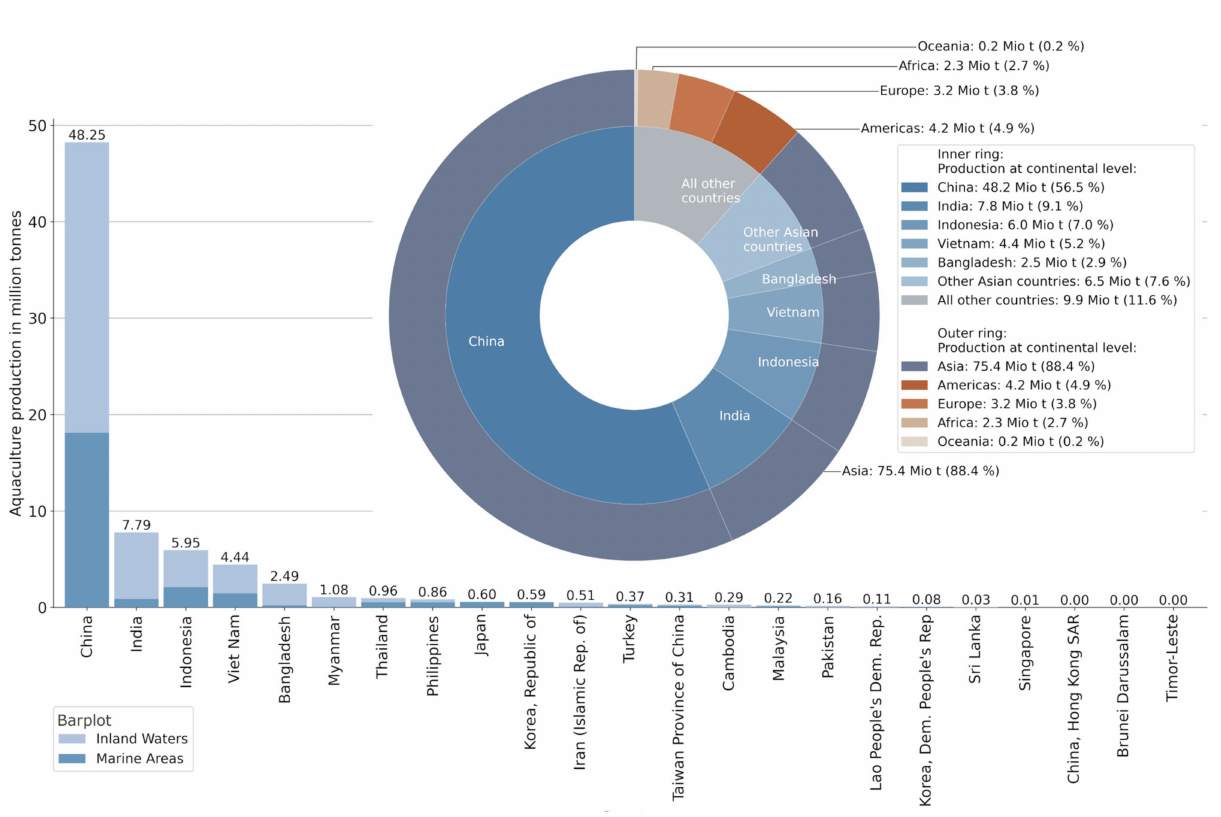
Figure 2. Bar chart: Aquaculture production in inland waters and marine areas among Asian countries in 2019; Donut chart: Share of aquaculture production among continents and the top 5 global producers in 2019. Data source: